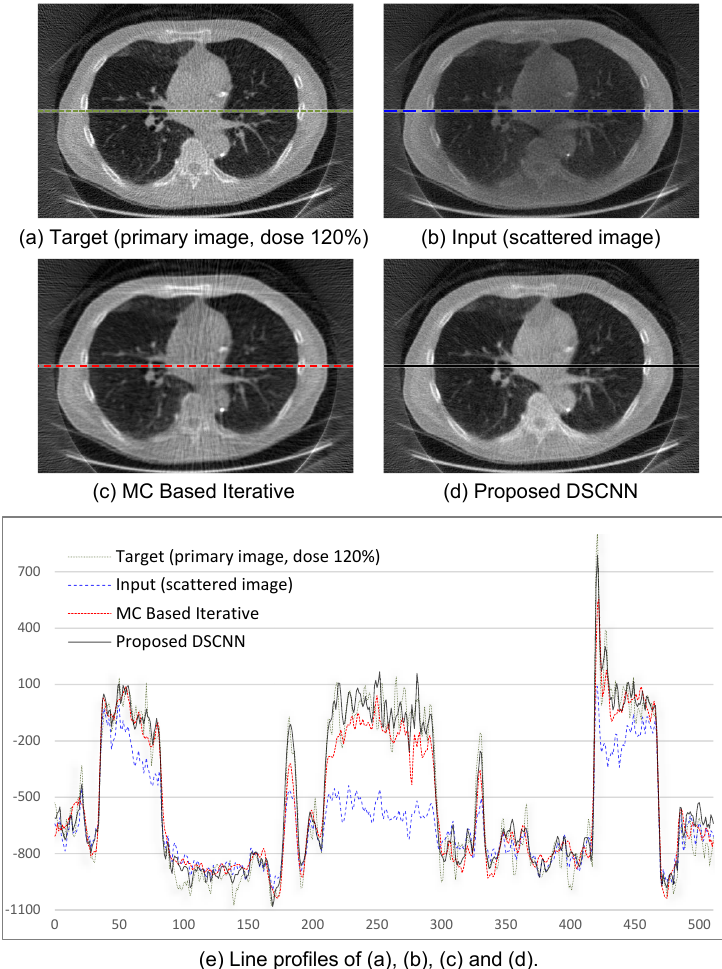
Figure 11. Comparison of axial images after reconstruction and the line profiles.